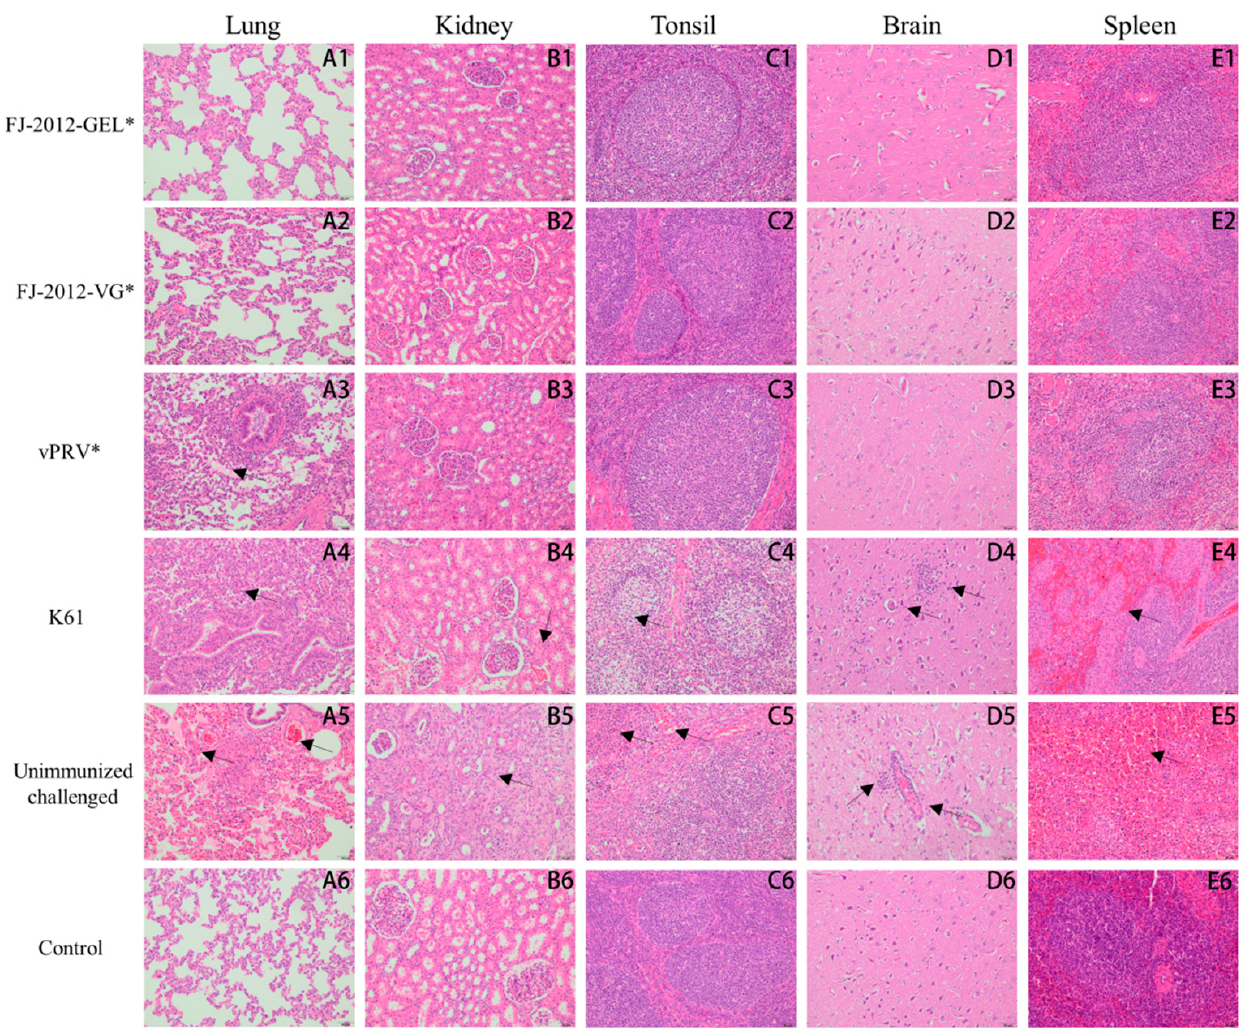
Figure 4. Histopathological findings of piglet tissues after PRV challenge. The letters A to E refer to the lung, kidney, tonsil, brain, and spleen, respectively. The numbers 1 to 6 represent the FJ-2012-GEL*, FJ-2012-VG*, vPRV*, K61, unimmunized challenged, and control groups, respectively. Hematoxylin and eosin staining (H.E.), Magnification, 200 × . The “*” mark in the group top right indicates an inactivated